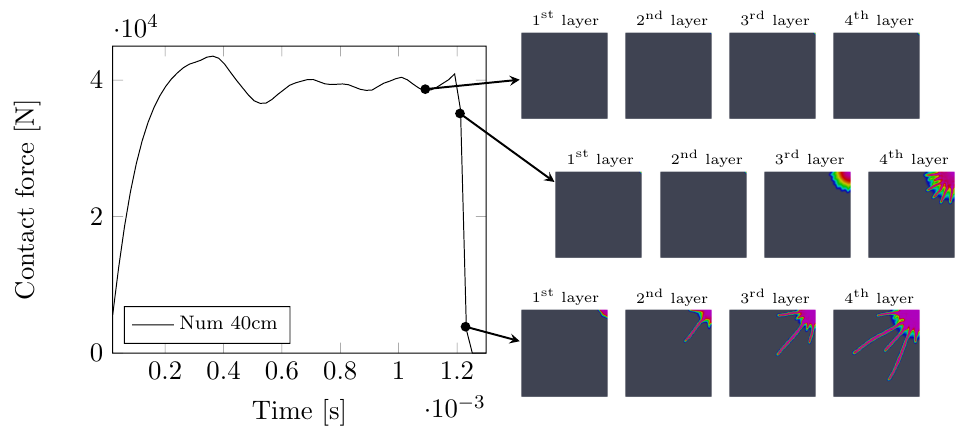
Figure 18. Evolution of cracks in 7LG laminate due to impact height h imp = 40 cm, the 1st layer is the impacted